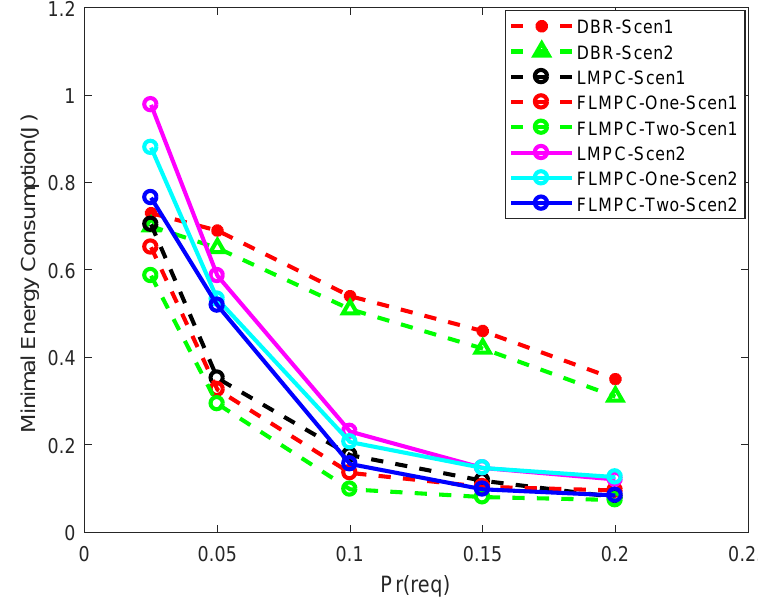
Figure 13. Required Packer Error Ratio.